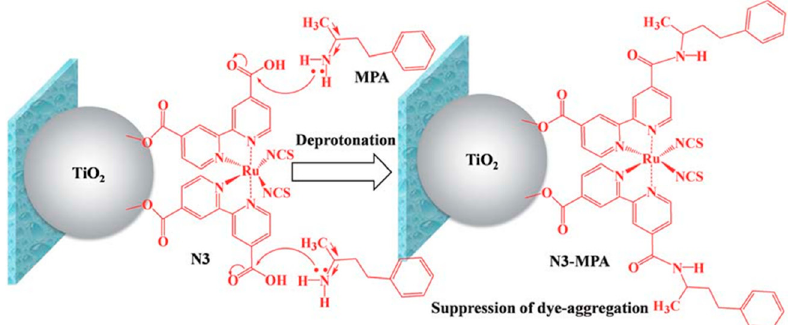
Figure 12. Schematic diagram for deprotonation of dye N3 (i.e., dye 51 ) on TiO 2 particles with MPA via an amide bond. Republished with permission of Royal Society of Chemistry from [95], permission conveyed through Copyright Clearance Center, Inc.